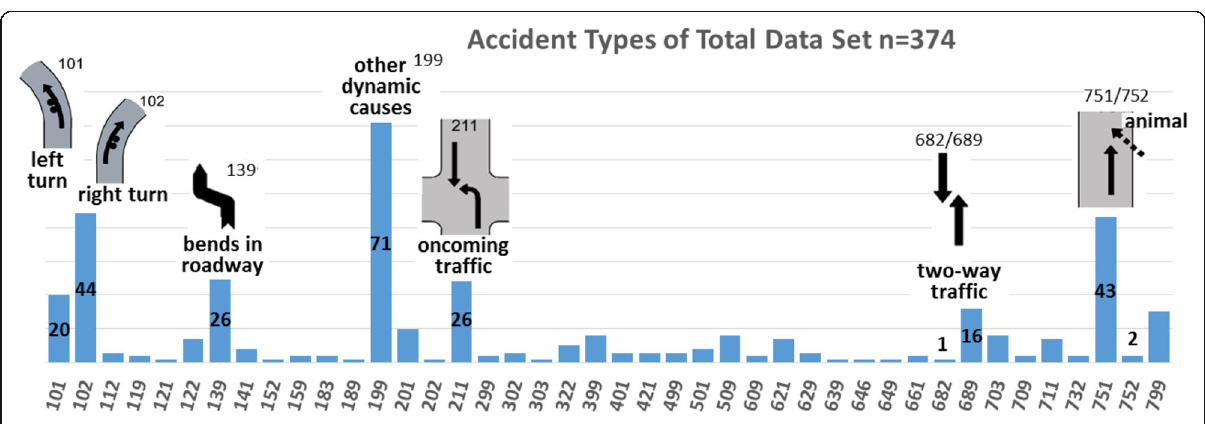
Fig. 11 Main areas of accident types (UTYP 101 – 799) with difficult weather